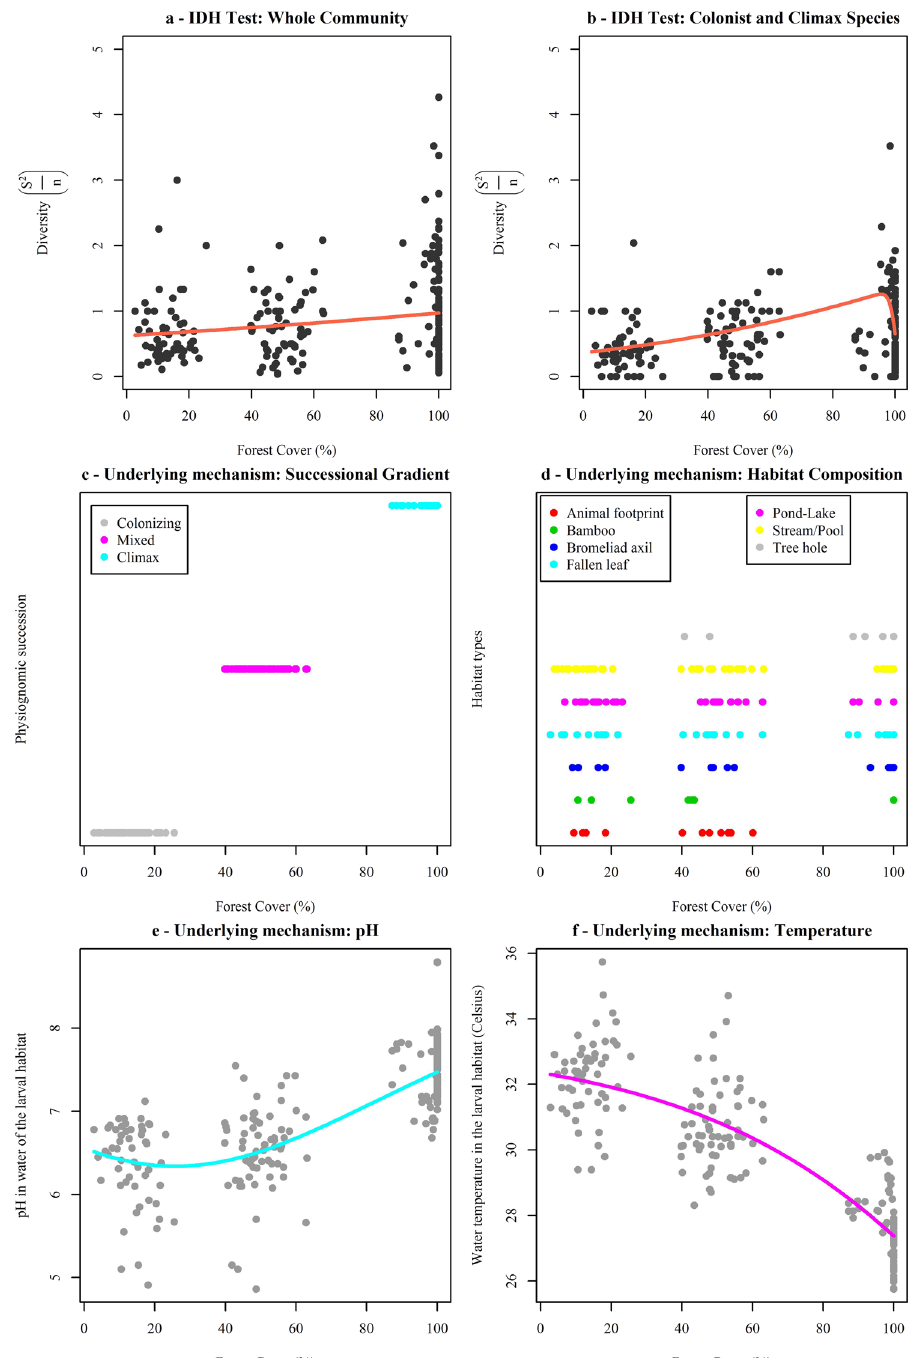
Figure 2. IDH testing. ( a ) whole community. The best-fitting curve was more plausible than the null model ( Δ AICc = 1.88; bootstrap likelihood ratio = 4:1) and meant that mosquito diversity increased as forest cover increased and vice-versa. ( b ) colonist and climax species (Connell’s fractions.). The best-fitting curve was slightly more plausible than the null model ( Δ AICc = 0.37; bootstrap likelihood ratio = 2.3:1). Underlying mechanisms: 1) habitat complexity, ( c ) successional gradient and ( d ) habitat composition; and 2) larval habitat constraints, (e) pH. The best-fitting curve was more plausible than the null model ( Δ AICc = 53.2) and (f) temperature. The best-fitting curve was more plausible than the null model ( Δ AICc = 1,006). R program-scripts and full results of multi-model selection are available upon